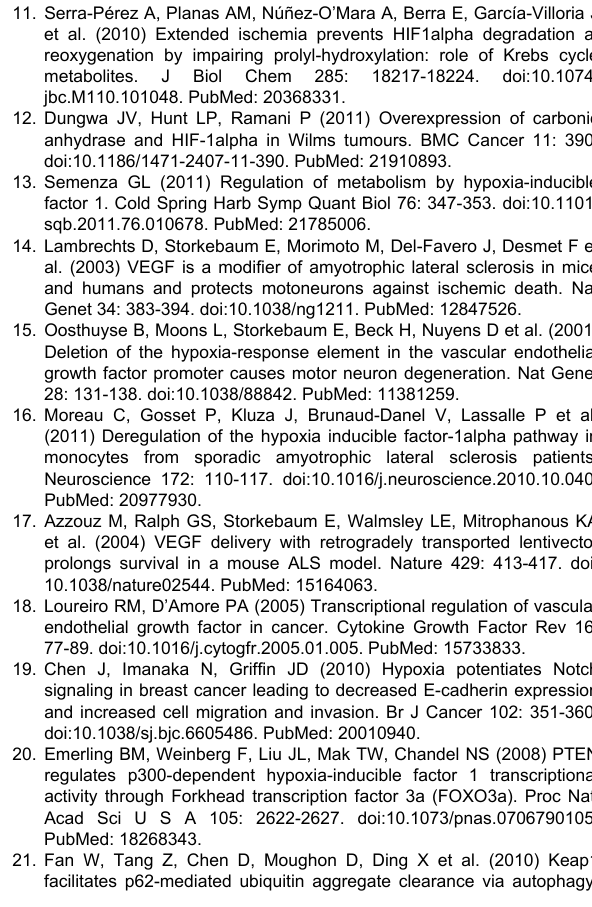
Figure S1. FAEs induce Nrf2 in astrocytes. Wild type astrocytes were treated with 30µM DEF (A, C) or 30µM DMF (B, D) for the indicated times. Nrf2 levels were measured in duplicates by western blot. *, p<0.05, **, p<0.01 significantly different from corresponding control (ANOVA followed by post- hoc Newman-Keuls). Values are the means +/- SEM of n=3